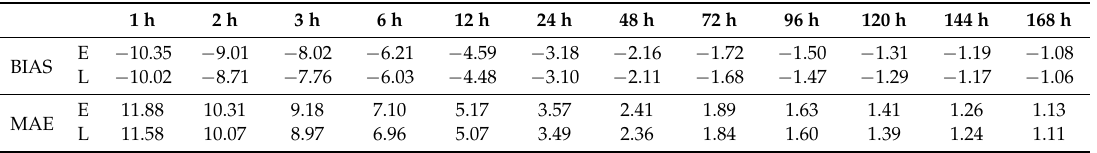
Figure 4. The bias ( a ) and mean absolute error ( b ) related to the heavy rainfall events: The orange boxplot refers to the GPM IMERG half-hourly early data while the red boxplot refers to the GPM IMERG half-hourly late data. Table 4. The bias and MAE values calculated both for the early (E) and for the late (L) products, taking into account only heavy rainfall conditions.